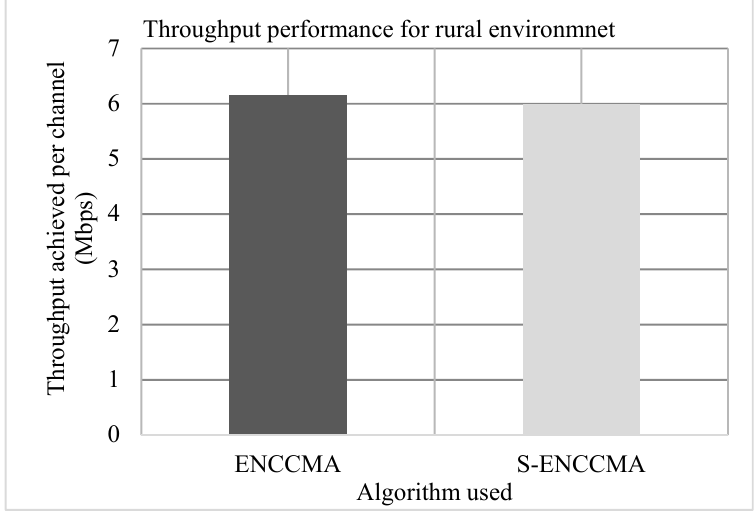
Figure 4. Highway environment throughput performance for varied vehicles. Sensors 2020 , 20 , x FOR PEER REVIEW